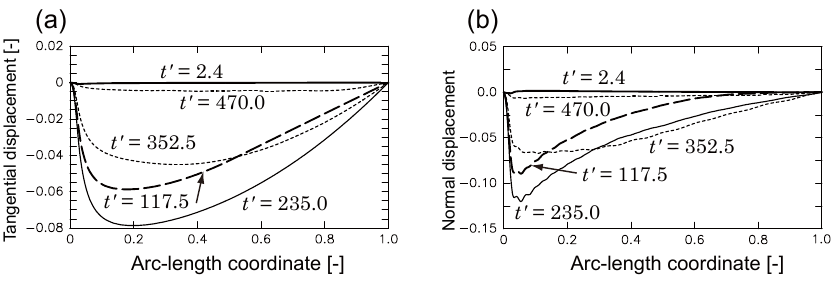
Figure 13. Time histories for the generalized coordinates of the lowest four modes for 250 buckets: ( a ) tangential component and ( b ) normal component.